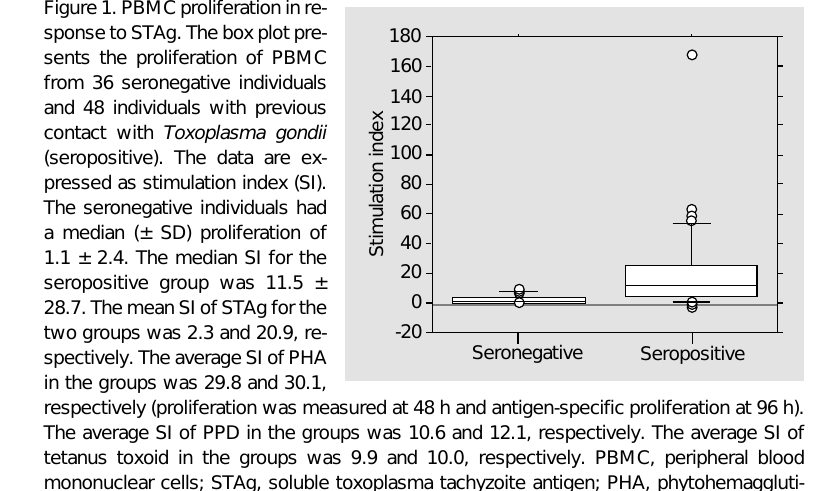
Figure 1. PBMC proliferation in re- sponse to STAg. The box plot pre- sents the proliferation of PBMC from 36 seronegative individuals and 48 individuals with previous contact with Toxoplasma gondii (seropositive). The data are ex- pressed as stimulation index (SI). The seronegative individuals had a median (± SD) proliferation of 1.1 ± 2.4. The median SI for the seropositive group was 11.5 ± 28.7. The mean SI of STAg for the two groups was 2.3 and 20.9, re- spectively. The average SI of PHA in the groups was 29.8 and 30.1, respectively (proliferation was measured at 48 h and antigen-specific proliferation at 96 h). The average SI of PPD in the groups was 10.6 and 12.1, respectively. The average SI of tetanus toxoid in the groups was 9.9 and 10.0, respectively. PBMC, peripheral blood mononuclear cells; STAg, soluble toxoplasma tachyzoite antigen; PHA, phytohemaggluti- nin; PPD, tuberculin purified protein